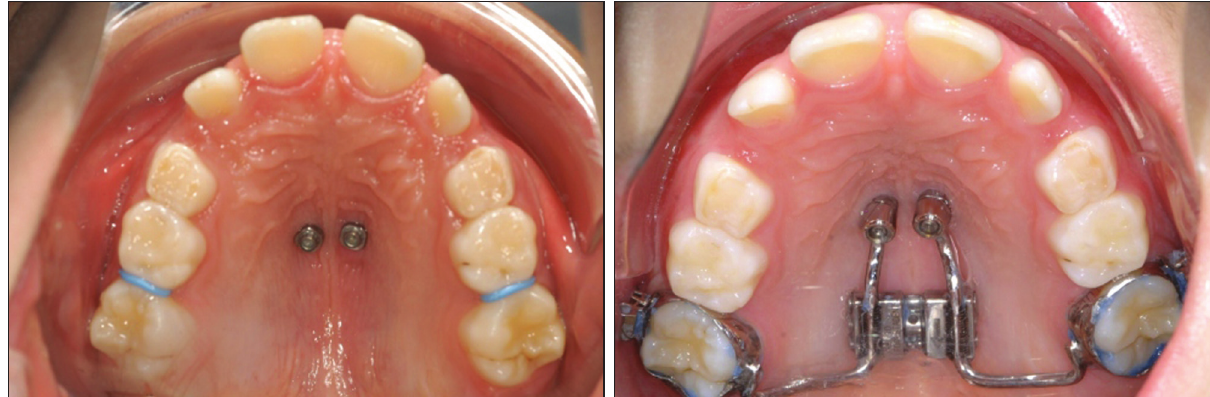
Figure 1. The Hybrid Hyrax (HH) anchored to two mini-implants in the anterior palate and upper molars (Source: University of Düsseldorf, Germany).